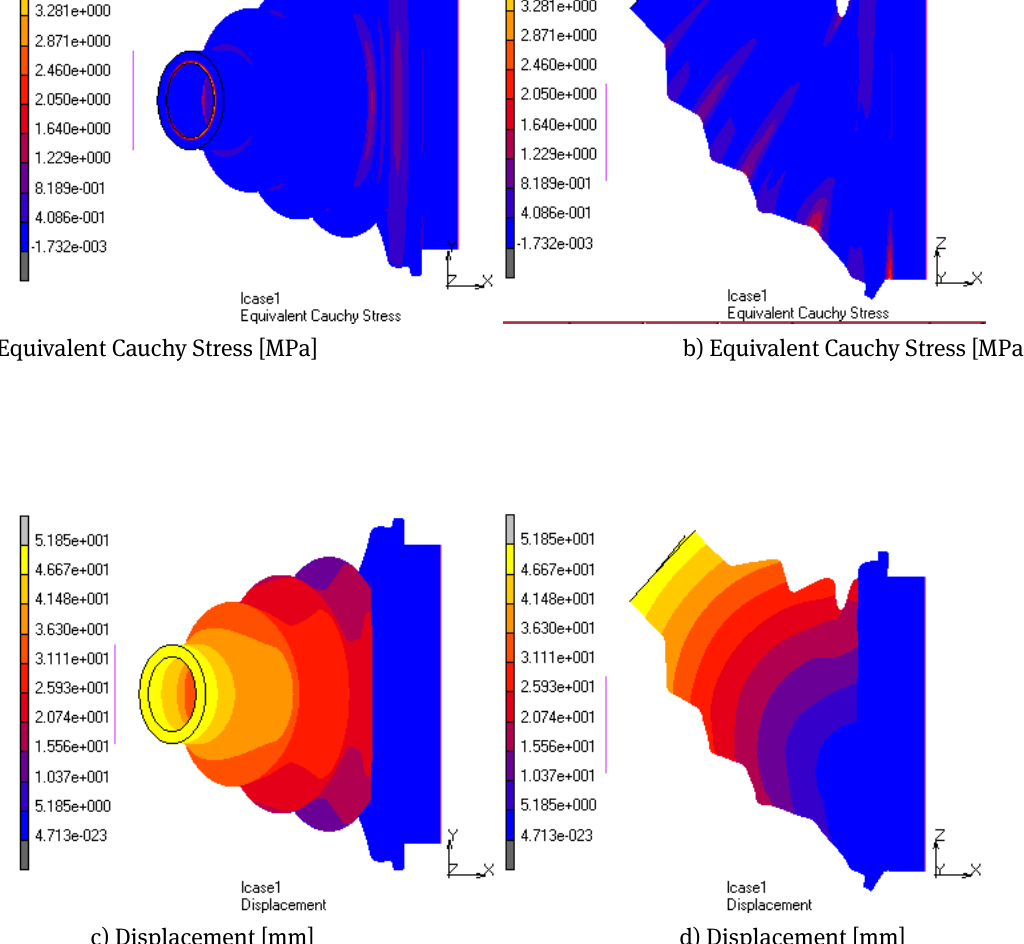
Figure 4: The Mapping of stresses and displacements rubber boot at angles twist: a) the Cauchy stress in the XY plane, b) the Cauchy stress in the XZ plane, c) the total displacement in the XY plane, d) the total displacement in the XZ